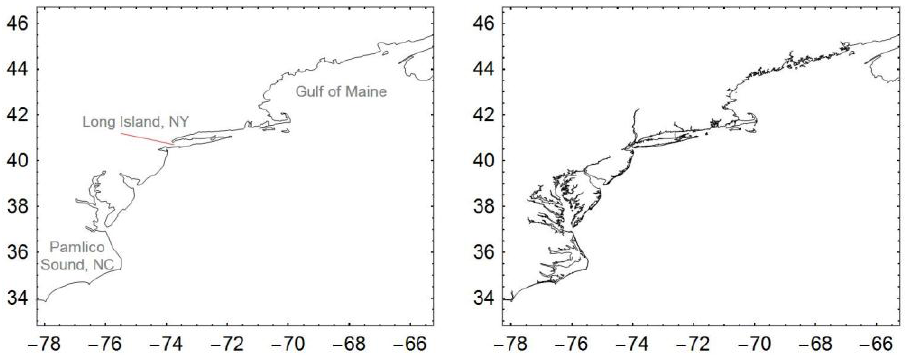
Figure 2. Comparison of coastal resolution in the EC2001 ( left ) and EC2015 ( right ) models from North Carolina to Maine.